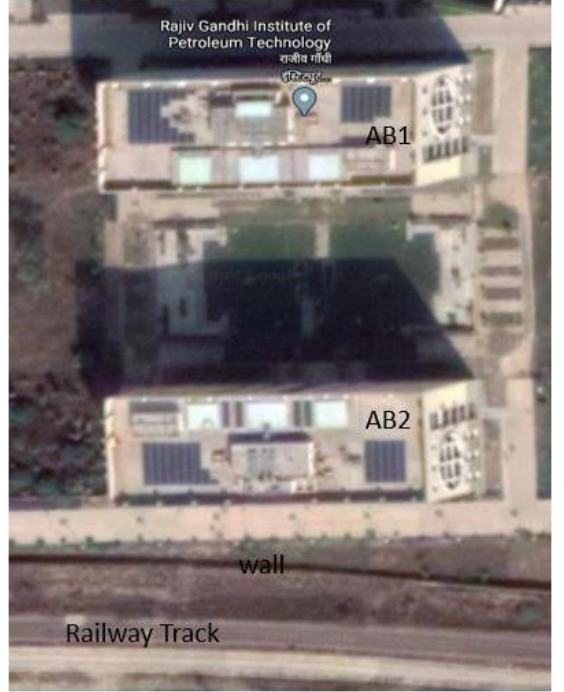
Figure 5. Rough Map of Noise at Ratapur Crossing, Deter- mined with Noise Data and Interpolated with Arc GIS using Google Image